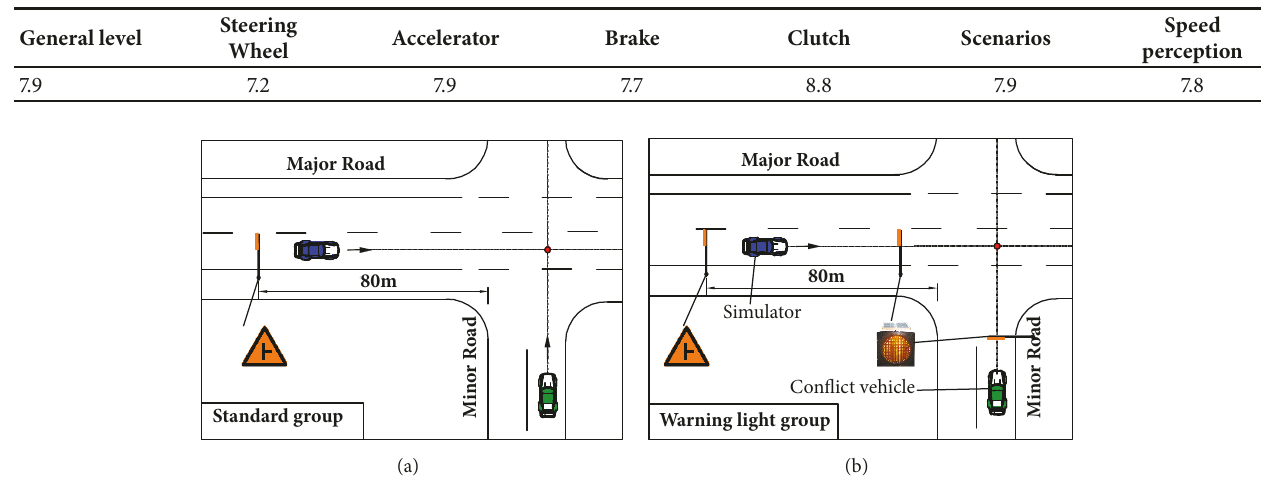
Table 3: Scores of driving authenticity.